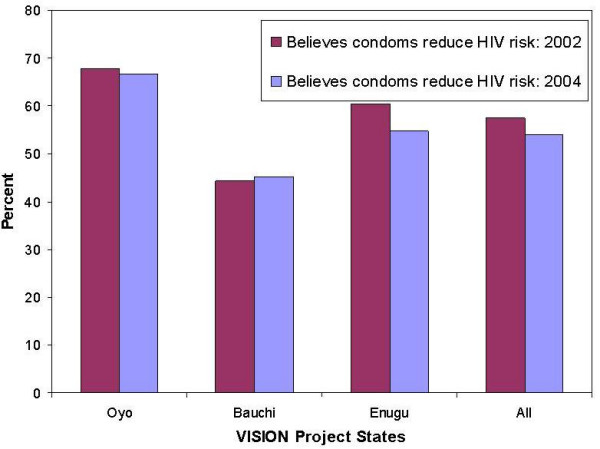
VISION outcome indicator in relation to 2002 baseline data: Condoms reduce HIV risk Figure legend text – Percentage of respondents that believe consistent condom use reduces risk of HIV infection: 2002 baseline and 2004 follow-up data. Aggregated estimates were calculated using weighted data